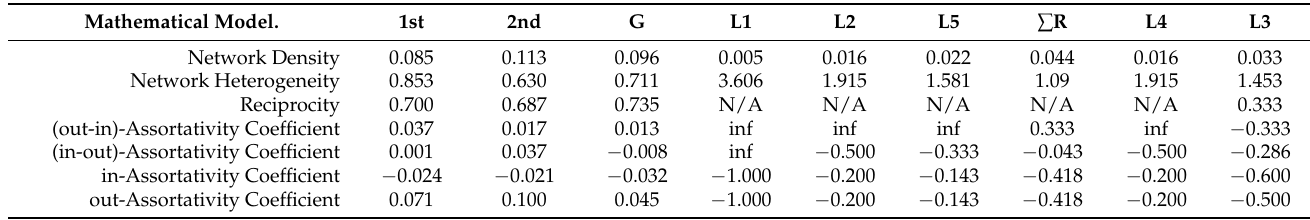
Table A12. Team B’s Matrix of values of the macro analysis mathematical